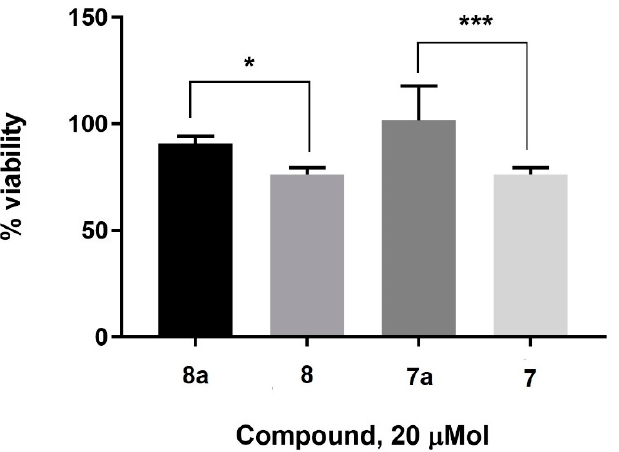
Figure 2. WI-38 cell % viability after 24 h exposition to synthesised drugs, compared to a control with no exposition to the drug (100% viability). Results reported in the chart as mean + SD expressed by error bar (5 repeats). One way ANOVA test was performed comparing results of dilactam compounds to imine-containing compounds (7a vs. 7 and 8a vs 8), * p < 0.05, *** p < 0.001.